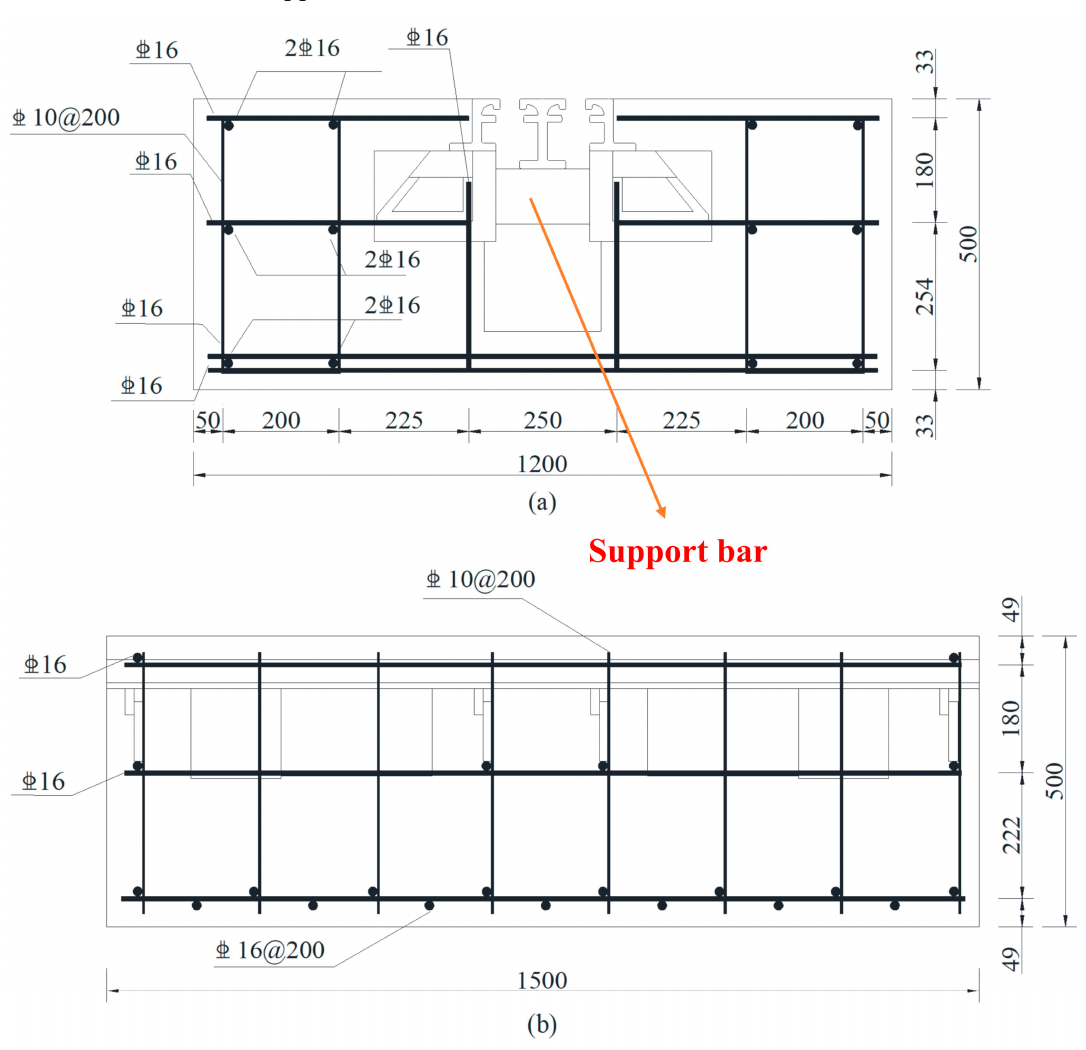
Figure 2. Details of the reinforcement of the specimen: ( a ) front view of the specimen; ( b ) side view of the specimen. Table 1. Material properties of Q345B.